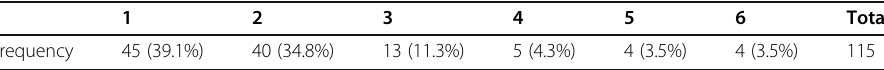
Table 13 Reasons for perceiving Part3 (a table providing the mastery probability of each attribute) as